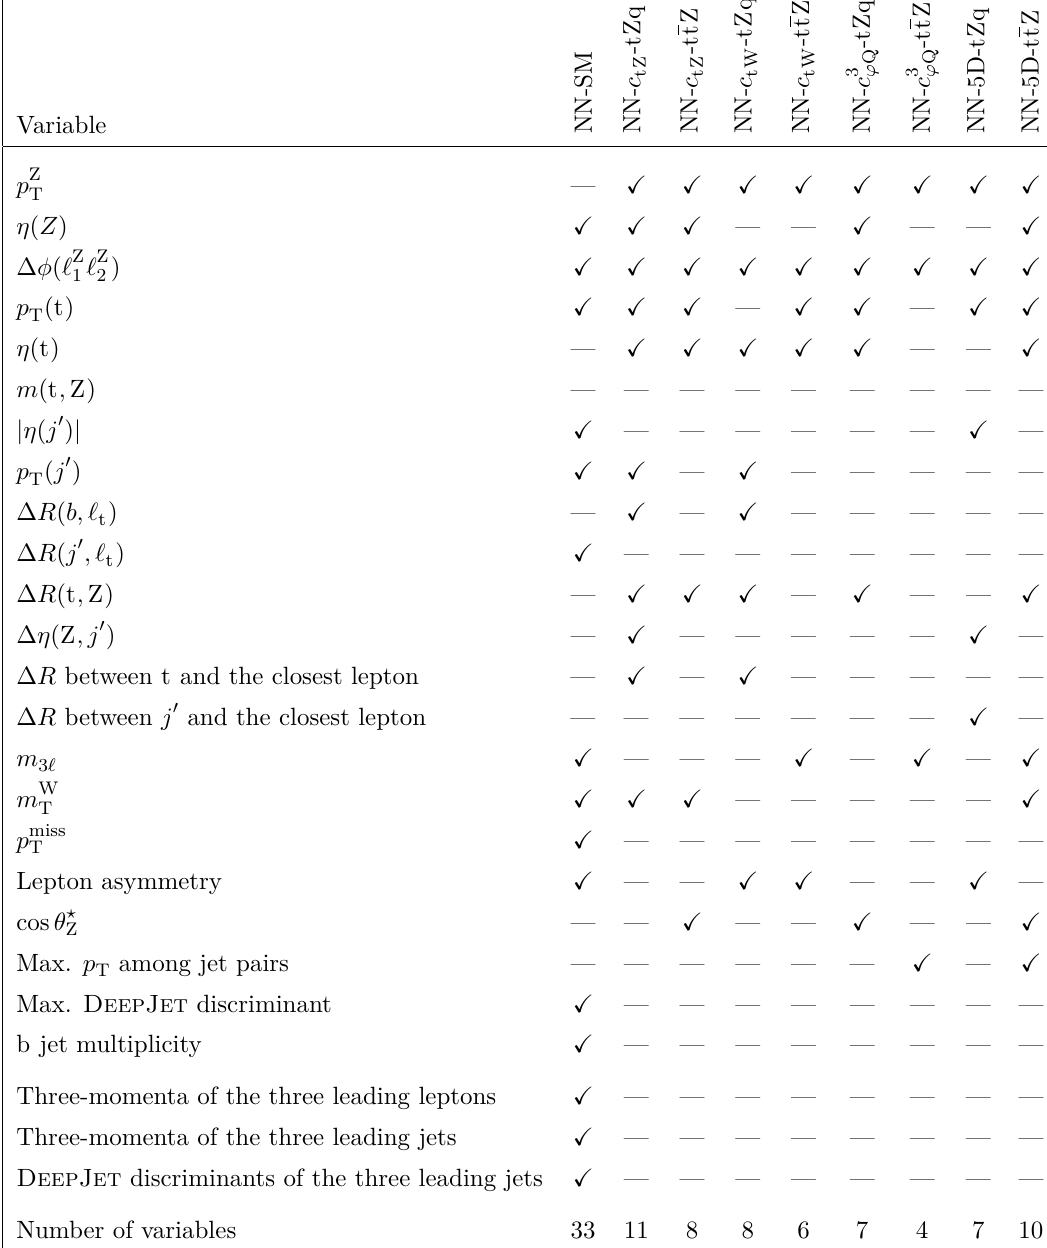
Table 3 . Input variables to the NN-SM and to the eight NN-EFTs. A dash indicates that the variable is not used. The three-momentum of an object includes the p momentum. The symbol ‘ denotes the lepton produced in the decay of the top quark; j 0 denotes t the recoiling jet; b denotes the b jet associated with the leptonic top quark decay; ( ‘ Z